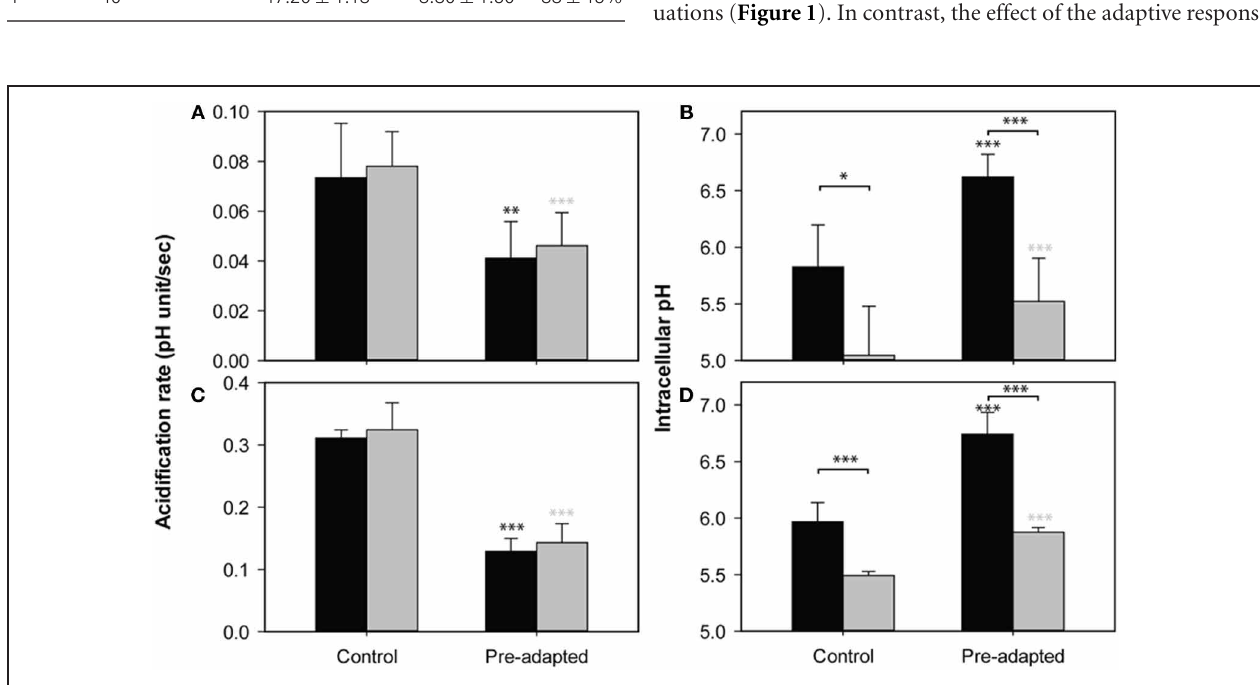
FIGURE 1 | Effect of WOA pre-exposure on acid entry. The rate of acidification (A,C) and pHi reduction after 1min (B,D) caused by 20mM acetic acid (A,B) or 1.2mM sorbic acid (C,D) , in control cultures (no pre-exposure) and culture pre-exposed to 45mM of HA (A,B) or 1mM of HS (C,D) . The same experiment was performed in the presence (black) and